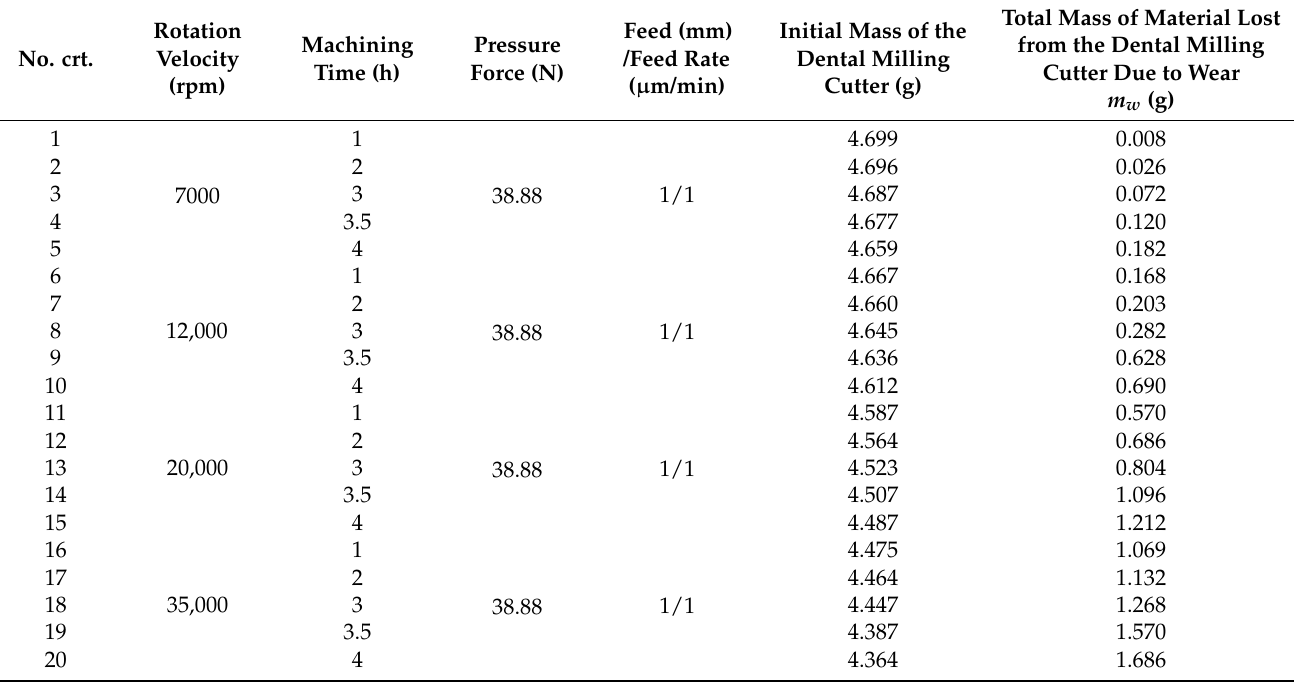
Table 2. Working regimes for processing the Ni-Cr sample with the dental milling cutter taken as a standard and determining material loss by